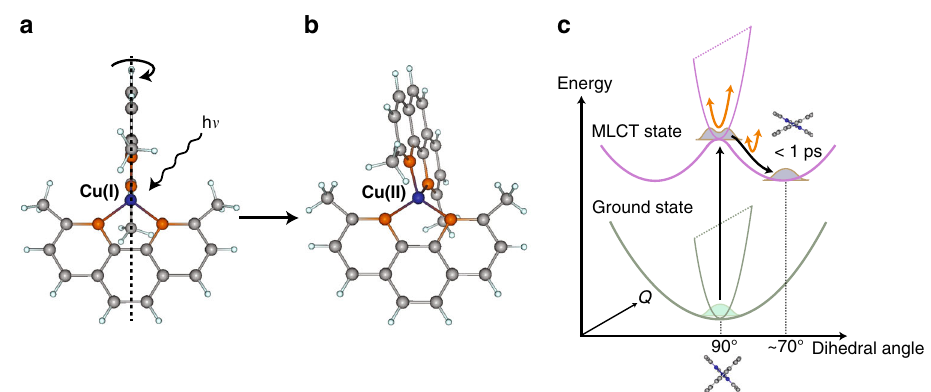
Fig. 1 Schematics of [Cu(dmphen) 2 ] + . a The structure of the ground S 0 state. The symmetry is D 2d , where two planar dimethyl-phenanthroline ligands coordinate to Cu perpendicularly. b The structure after the PJT distortion triggered by photoinduced MLCT excitation. The symmetry is reduced to D 2 by the fl attening of the dihedral angle between two dimethyl-phenanthroline ligands. c Potential energy surface landscape upon which the molecules relax into the PJT